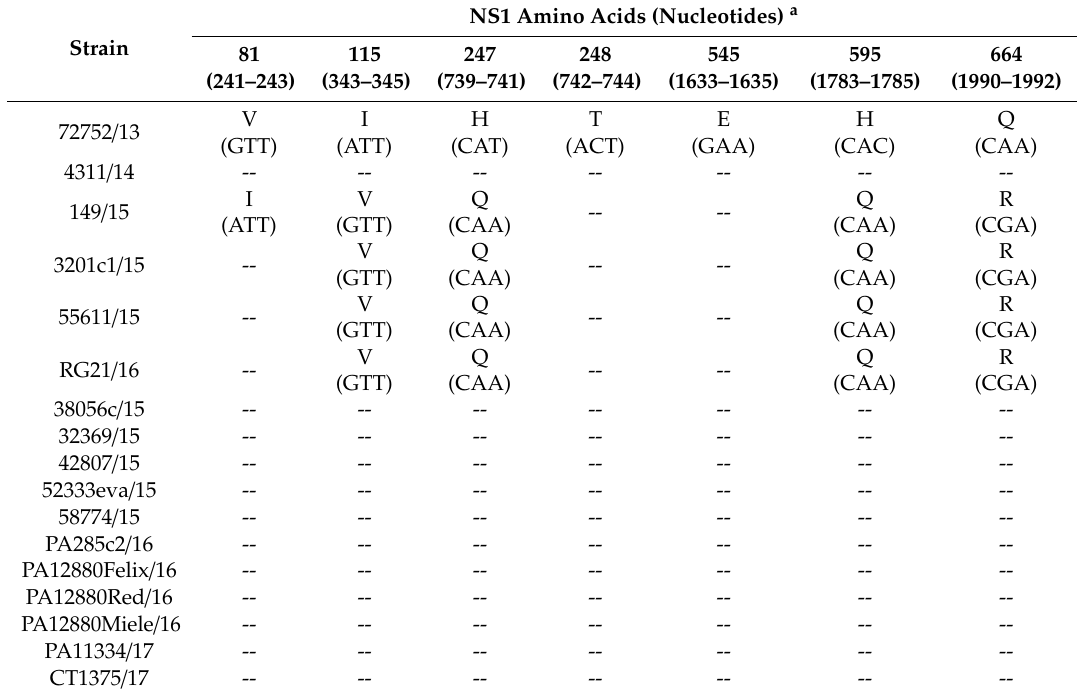
Table 2. NS1 non-synonymous changes of analyzed FPLV strains described in this